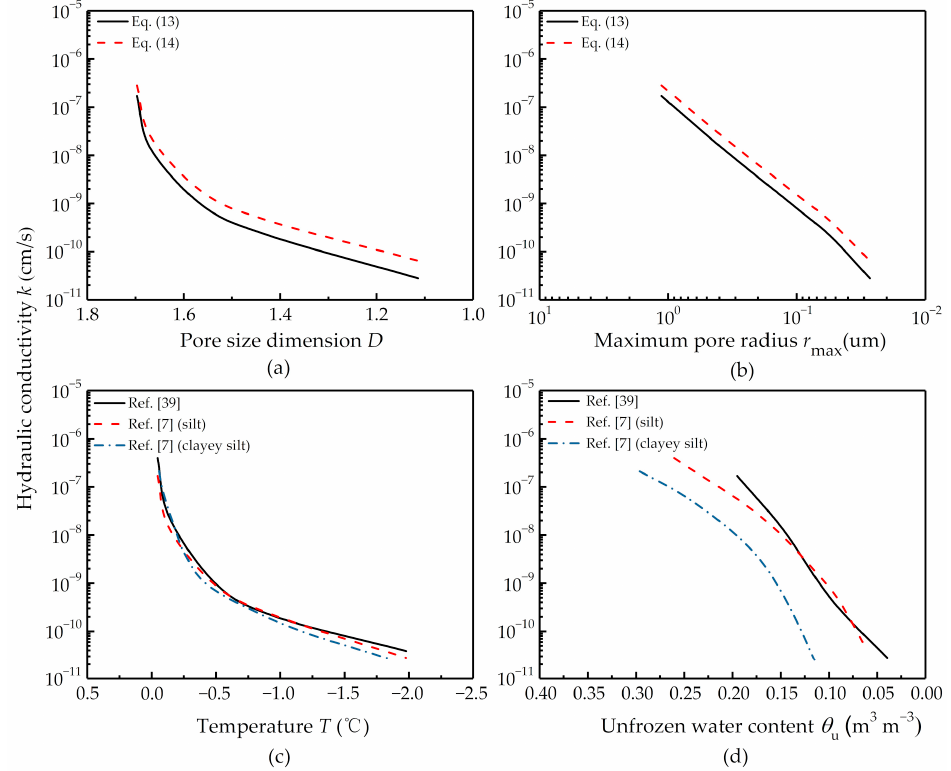
Figure 8. The effect of pore size dimension ( a ), maximum pore radius ( b ), temperature ( c ) and unfrozen water content ( d ) on hydraulic conductivity.